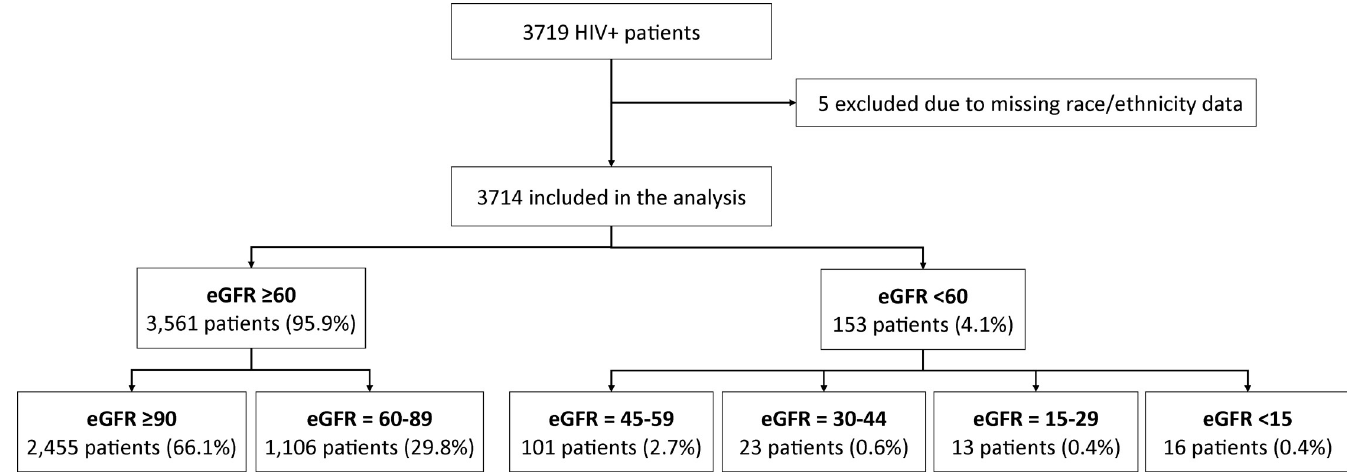
Fig 1. Study flowchart to establish cohort of patients with and without CKD. eGFR unit: ml/min/1.73m 2 .